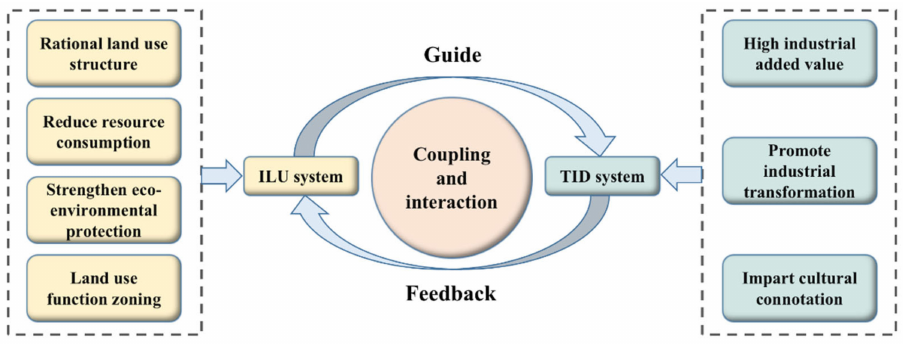
Figure 2. Coupling and interactive mechanism of ILU and